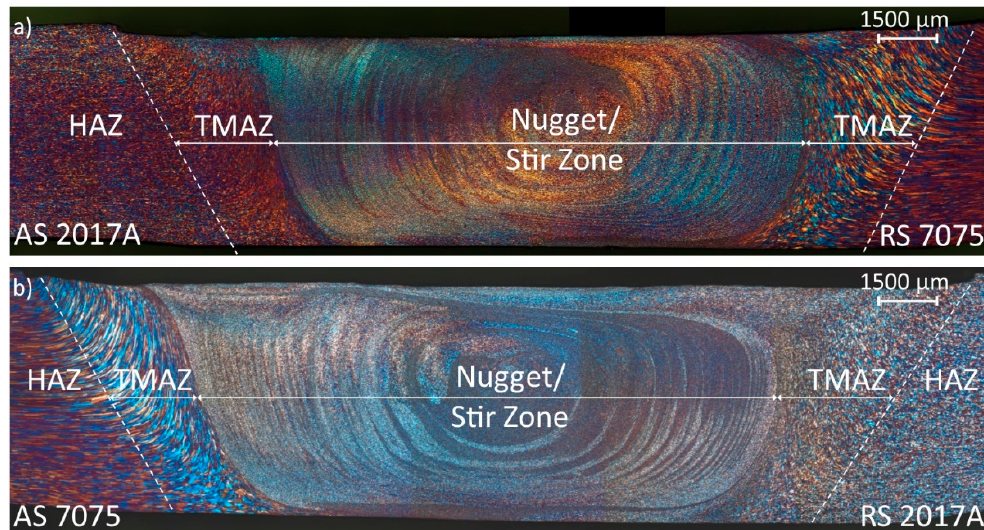
Figure 1. Macrographs of the weld configurations with the characteristic friction stir-weld zones noted, i.e., the nugget/stir zone, the thermo-mechanically affected zone (TMAZ) and heat-affected zone (HAZ): ( a ) AS 2017A/RS 7075 and ( b ) AS 7075/RS 2017A (AS: advancing side and RS: retreating side) [10].